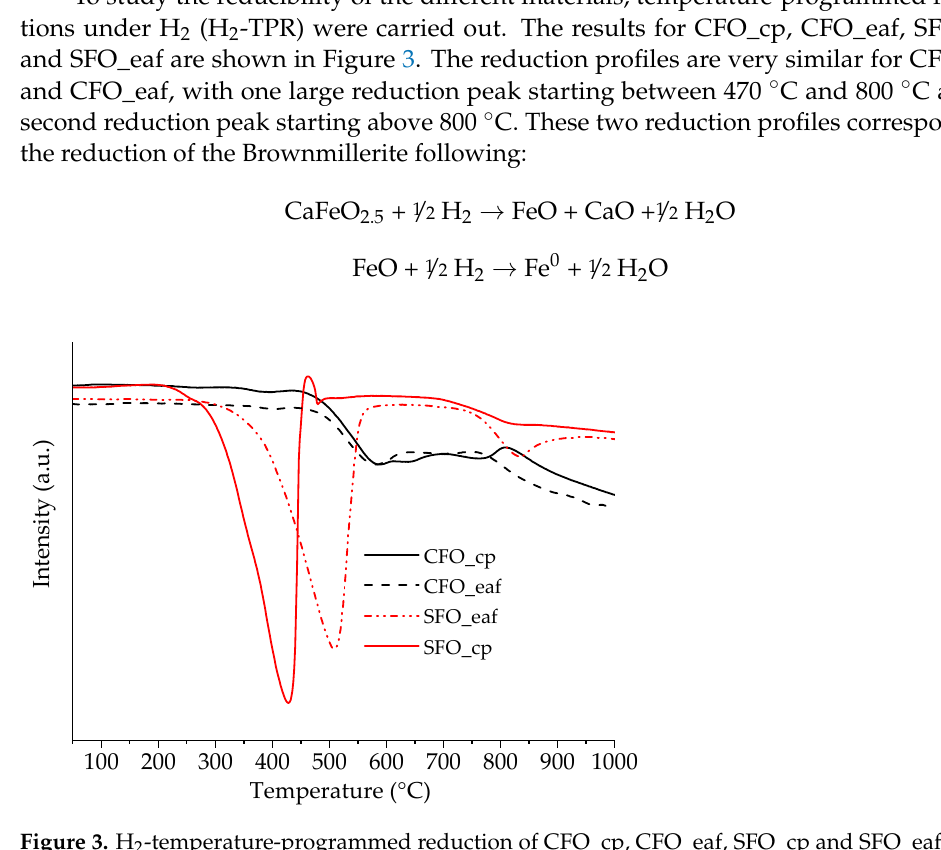
200 mg catalyst, total flow: 10 L/h. mg catalyst, total flow: 10l/h.